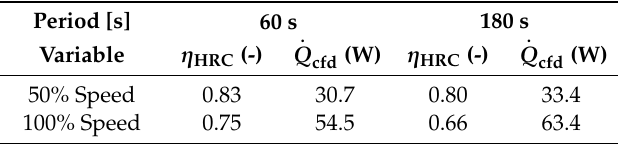
Figure 14. Supply and exhaust heat transfer rate comparisons for the measurements and the computational fluid dynamics (CFD) simulation.